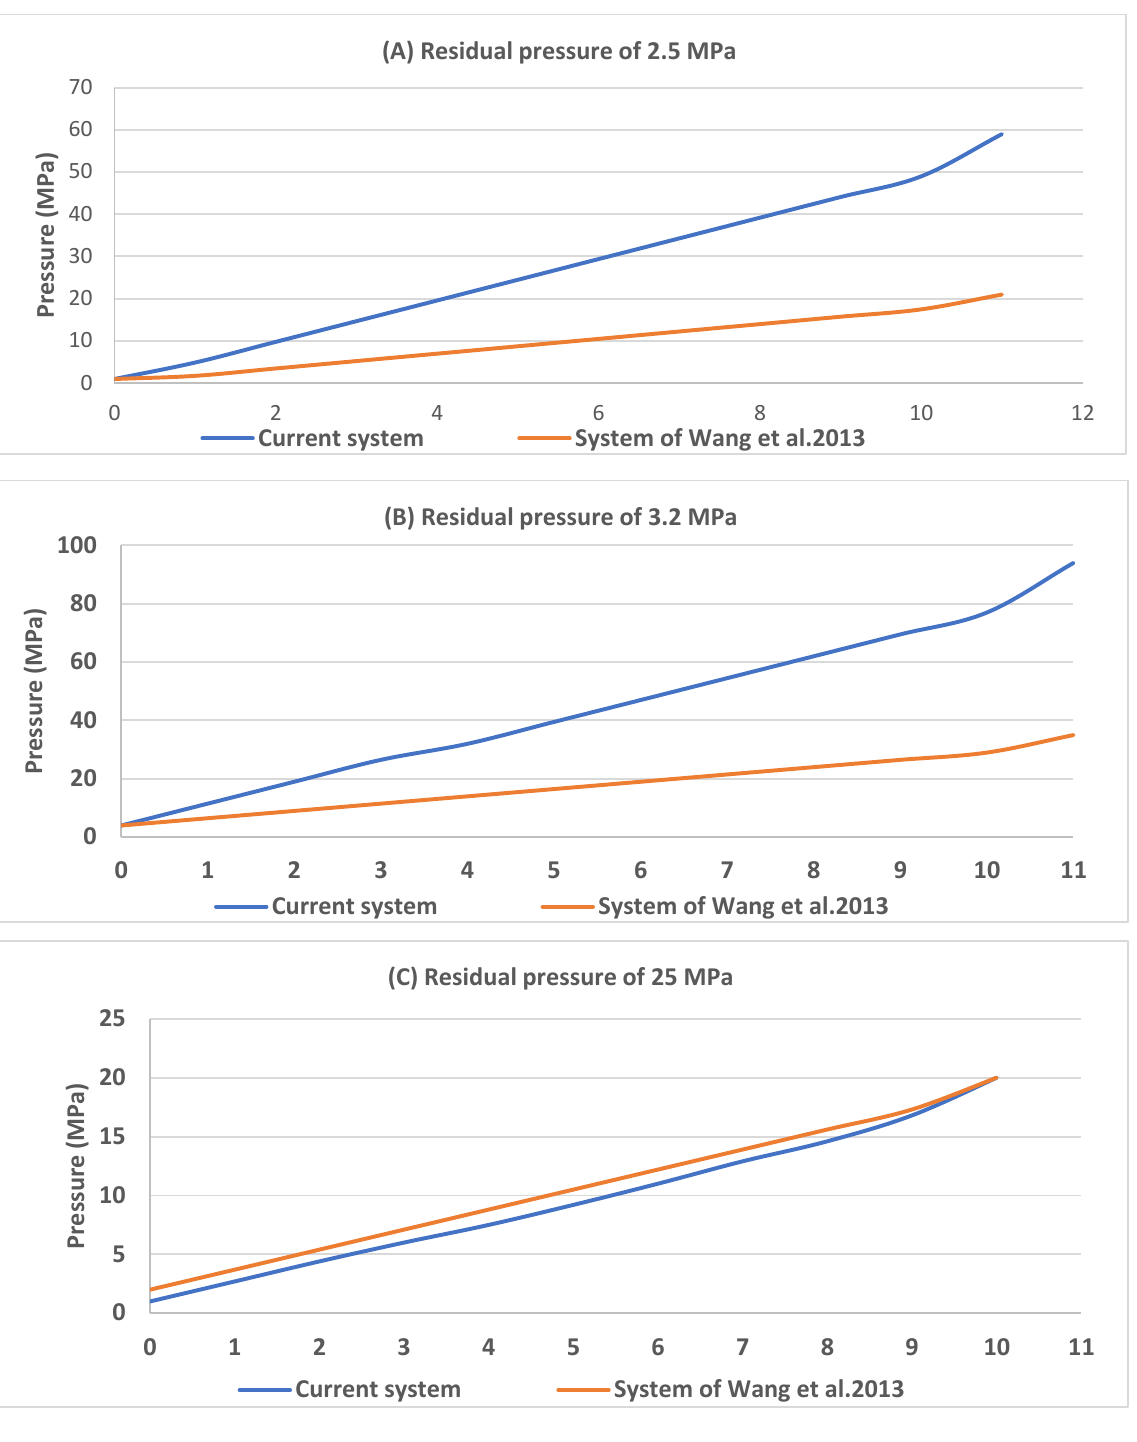
Figure 6. Pressure changes for a residual pressure of: ( A ) 2.5 MPa; ( B ) 3.2 MPa and; ( C ) 25MPa compared to ϵ for the three studies in three different states.